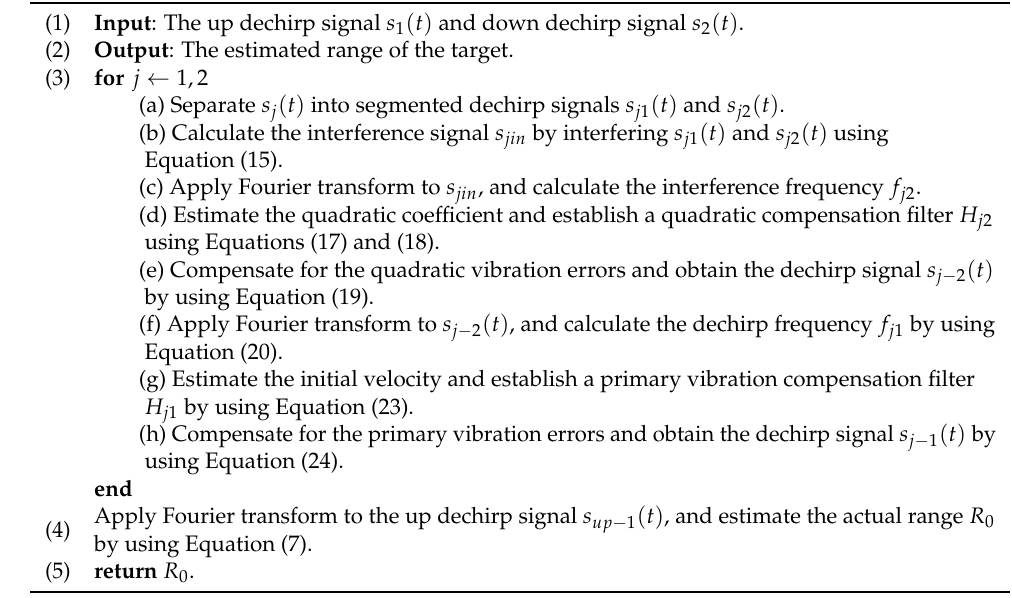
Table 1. Process flow of the proposed vibration compensation